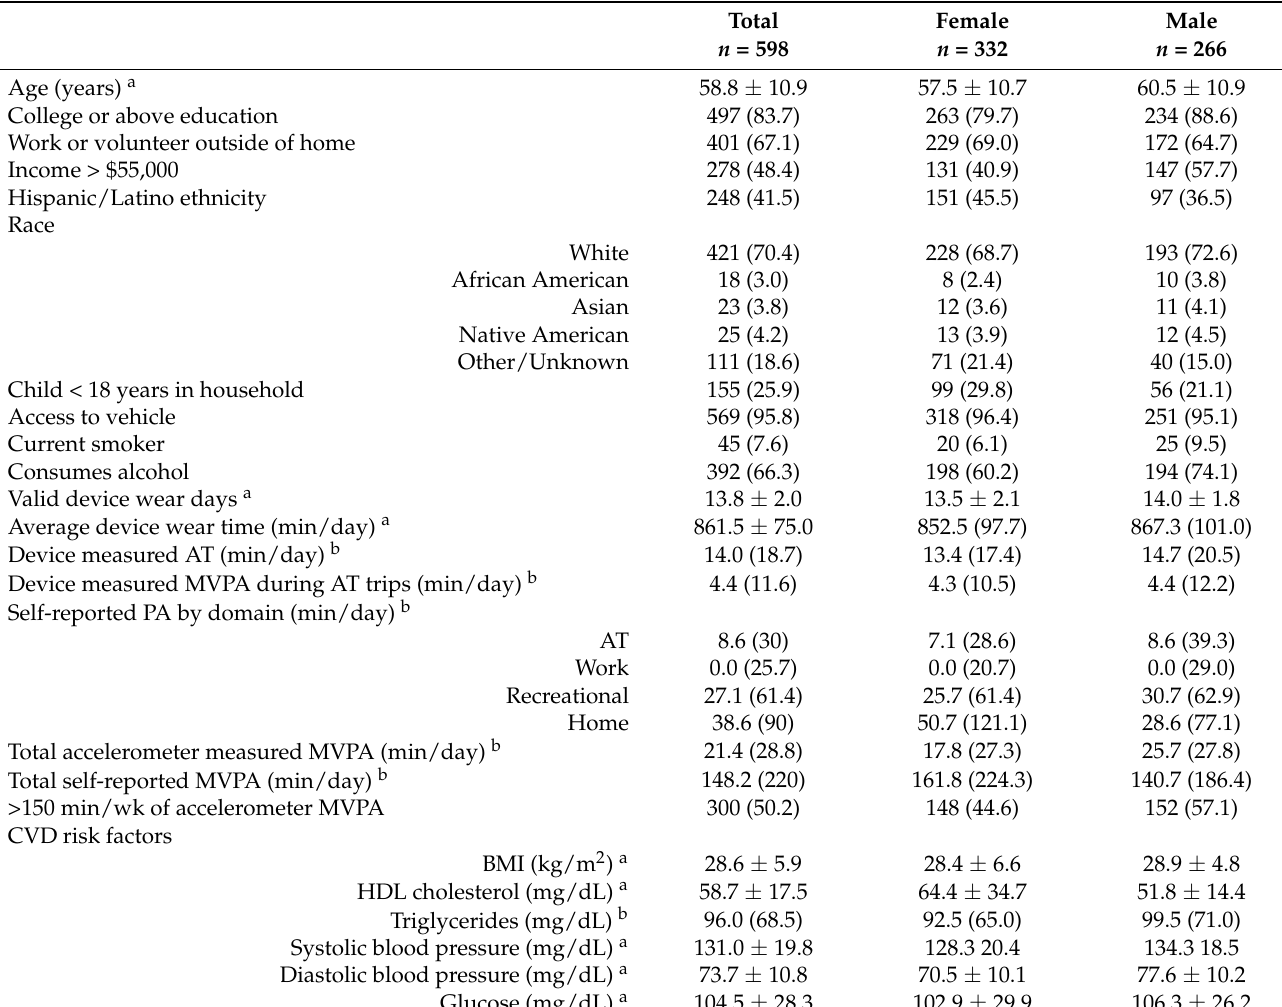
Table 1. Demographics and baseline characteristics of the study